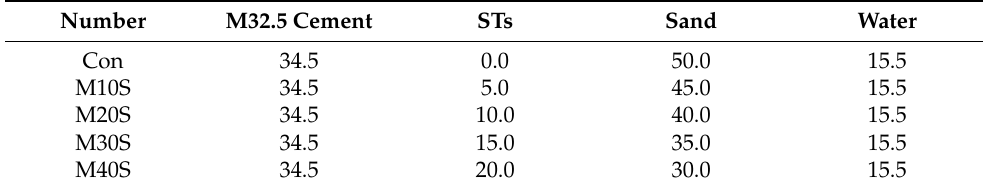
Table 2. The mix proportion of mortars for investigating the effect of STs content on the properties of mortars (g/100 g).